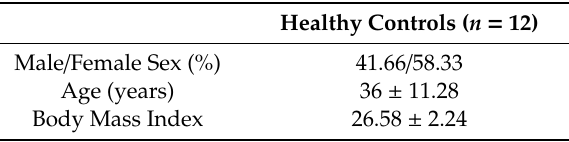
Table 2. Baseline characteristics of healthy